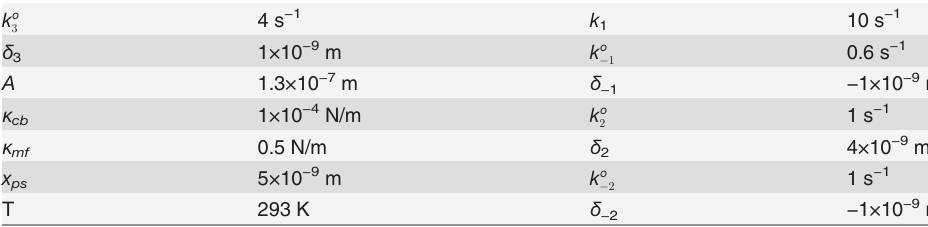
Table 1. Parameter values for the model of a half-sarcomere.